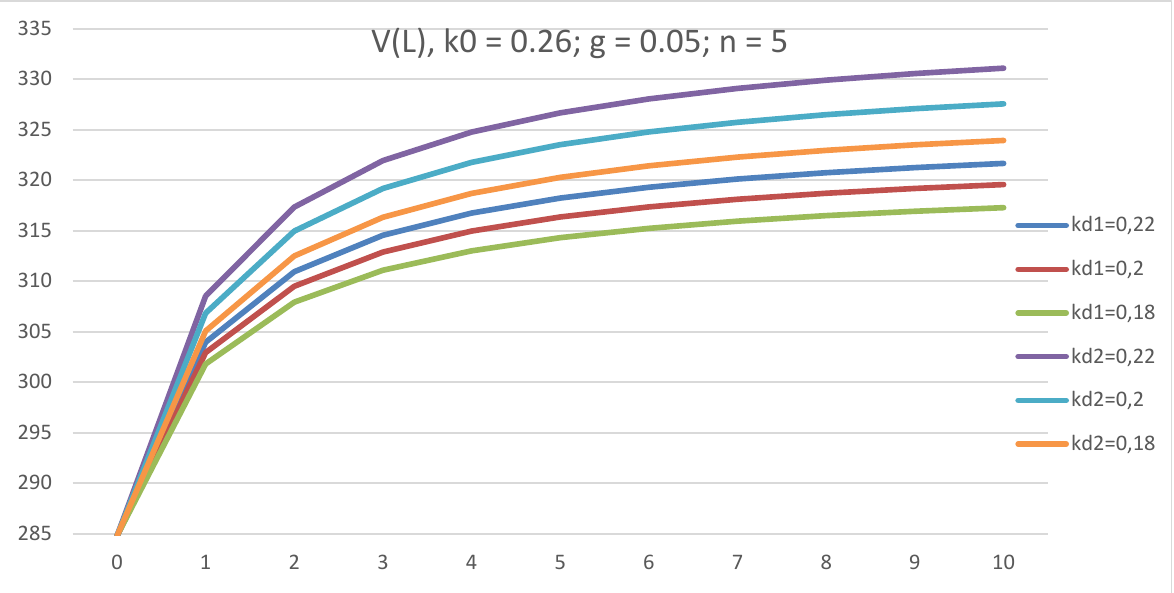
Figure 7. The dependence of company value, V, on leverage level, L, in GBFO theory with payments of tax on profit at the end of periods (1) and advance payments (2) at k 0 = 0.26; k d = 0.22; 0.2; 0.18; t = 0.2; g = 0.05, for a five-year company.